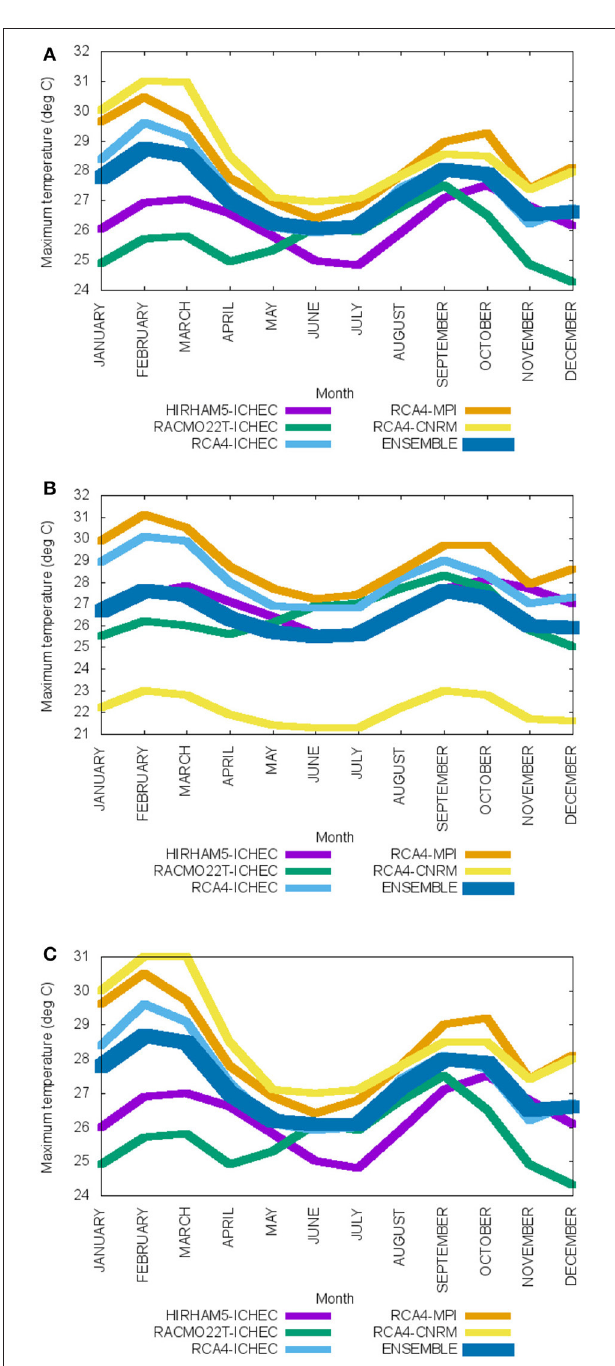
FIGURE 2 | Projections of maximum temperature over Tanzania (A) in present (2011–2040), (B) mid (2041–2070), and (C) end (2071–2100) centuries under RCP 4.5 emission